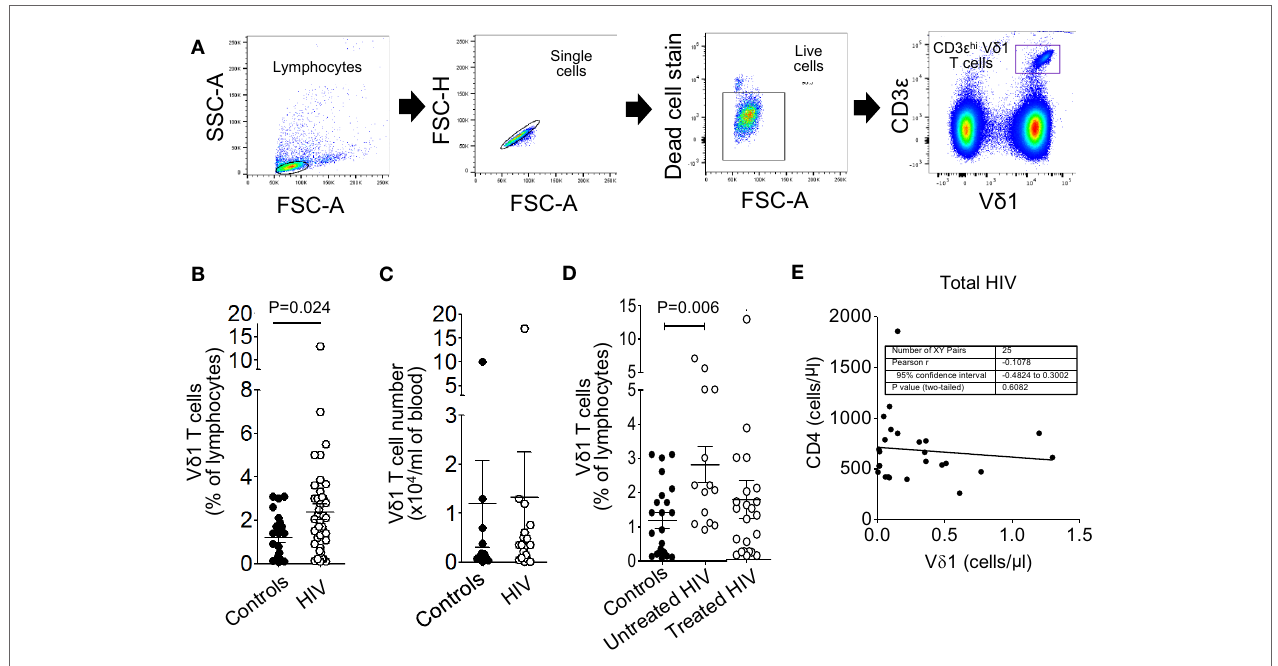
FigUre 1 | Circulating V δ 1 T cell frequencies but not numbers are higher in patients with untreated human immunodeficiency virus (HIV) infection. Peripheral blood mononuclear cells were prepared from blood samples of 36 patients with HIV infection and 23 healthy donors, stained with monoclonal antibodies specific for CD3 and the V δ 1 T cell receptor and analyzed by flow cytometry. (a) Gating strategy for the enumeration of V δ 1 T cells, showing sequential gates on the lymphocytes, single cells, live cells, and V δ 1 T cells. (B,c) Scatter plots showing circulating V δ 1 T cell frequencies (B) and absolute numbers (c) . (D) Scatter plots showing V δ 1 T cell frequencies in control subjects ( n = 23) and HIV patients divided into untreated ( n = 14) and antiretroviral therapy-treated ( n = 22) groups. Groups were compared using the Mann–Whitney U test. (e) Correlation between absolute counts of V δ 1 T cells and total CD4 + T cells in the blood of 25 patients with HIV